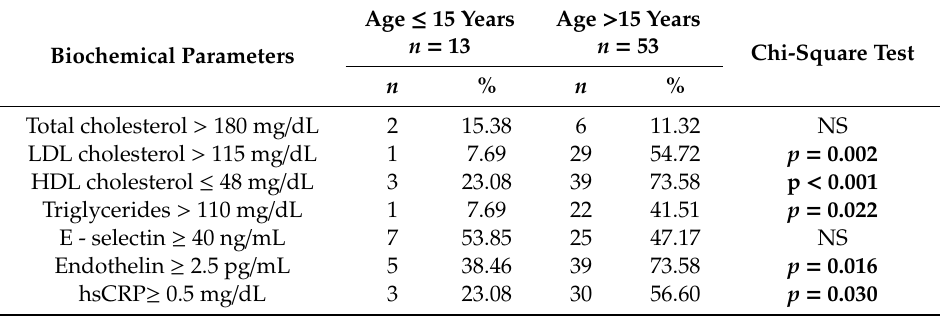
Table 8. Concentrations of the selected endothelial dysfunction markers and lipid metabolism parameters in the patients with RP in relation to